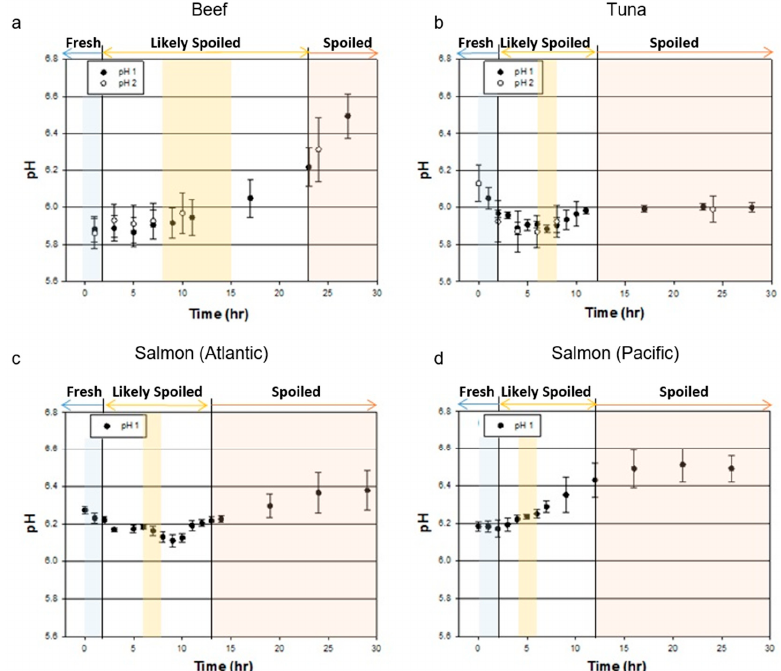
Figure 2. Time series of pH values for food samples to determine freshness: ( a ) beef, ( b ) tuna, ( c ) Atlantic salmon, and ( d ) Pacific salmon. At each time slot, the data point is for the mean of 60 measurements (3 sample × 20 measurements), and the bar represents the standard deviation of them. There were two separate rotting processes in the beef and tuna experiments, which are presented as pH1 and pH2. Spectral response data collected during the shaded time slots (blue, yellow, and red) were used for the machine learning model.